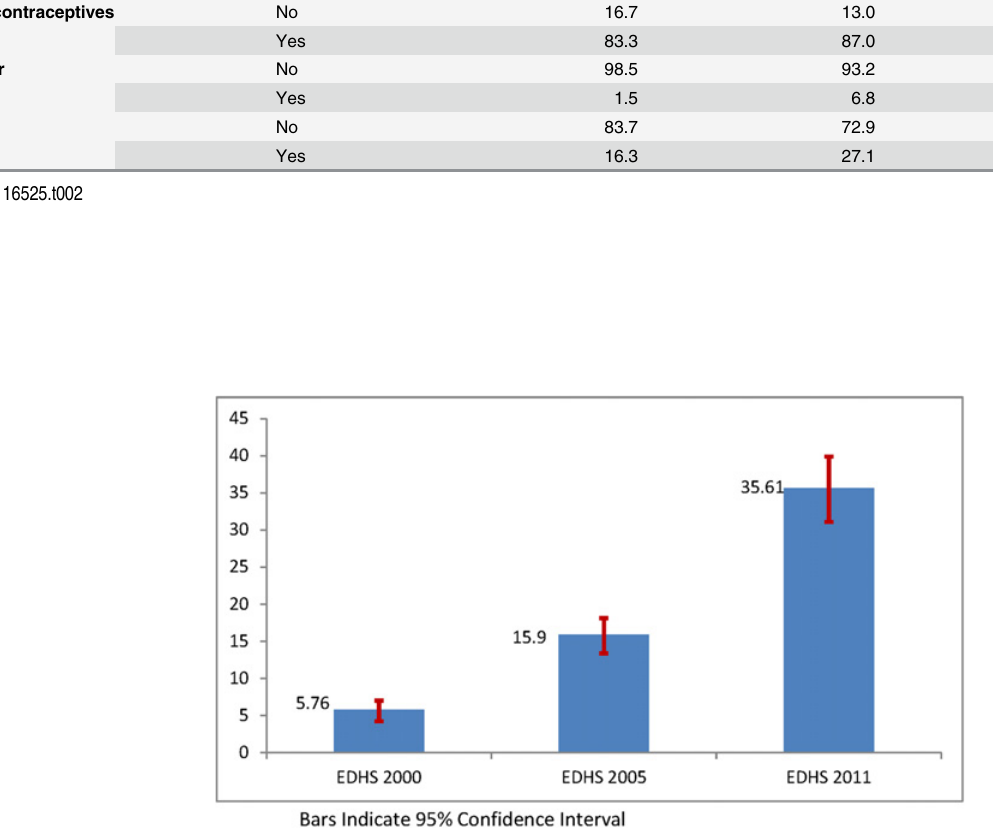
Figure 3. Trends in contraceptive use among Ethiopian young married women in the past 10 years, Ethiopia Demographic and Health Surveys 2000 –